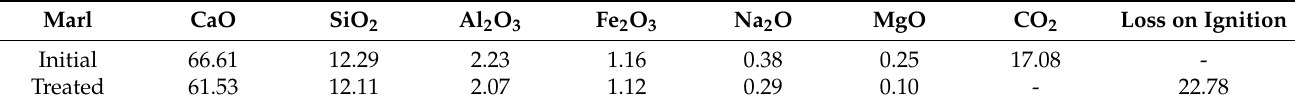
Table 1. Chemical composition of the raw, wt.%.